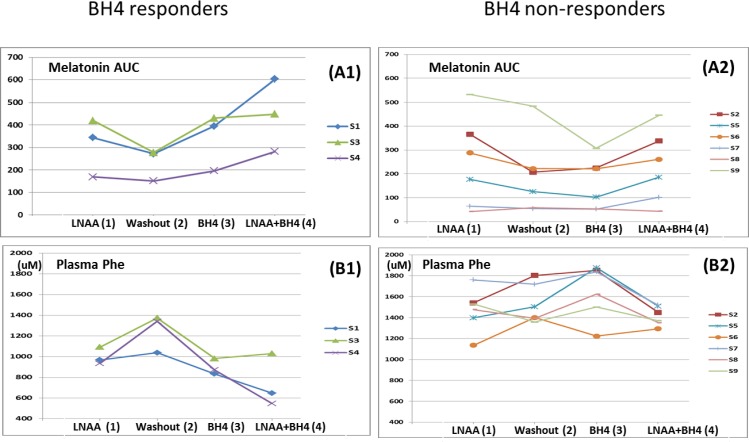
Overnight serum melatonin AUC (A) and Plasma phenylalanine concentrations (B) over the 4 phases. Phase 1 (LNAA), Phase 2 (Washout), Phase 3 (BH4) and Phase 4 (BH4 + LNAA). A1 and B1: BH4 responders. A2 and B2: BH4 non-responders. All BH4 responders showing significant decrease in plasma Phe levels, increased serum melatonin (Phase 3 vs. Phase 2 and Phase 4 vs. Phase 1). BH4 non-responders did not show increases in serum melatonin levels (Phase 3 vs Phase 2 and Phase 4 vs. Phase 1). All BH4 responders and S2, S5, S6, and S9 (4 out of 6 subjects) increased serum melatonin with LNAA (Phase 2 vs. Phase 1). All BH4 responders and S2, S5, S6, S7, and S9 (5 out of 6 subjects) increased serum melatonin with BH4 and LNAA over BH4 only (Phase 4 vs. Phase 3).